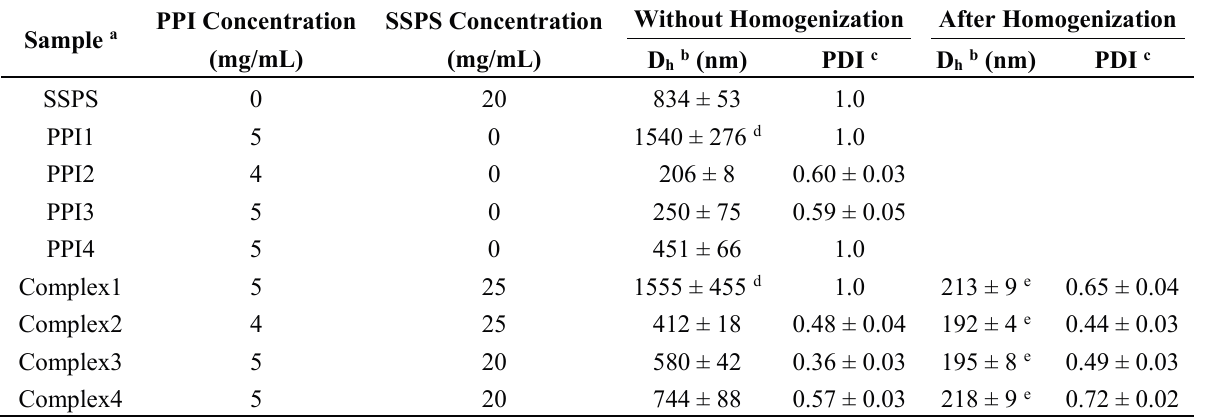
Table 2. DLS results of PPI, SSPS, and PPI/SSPS complex